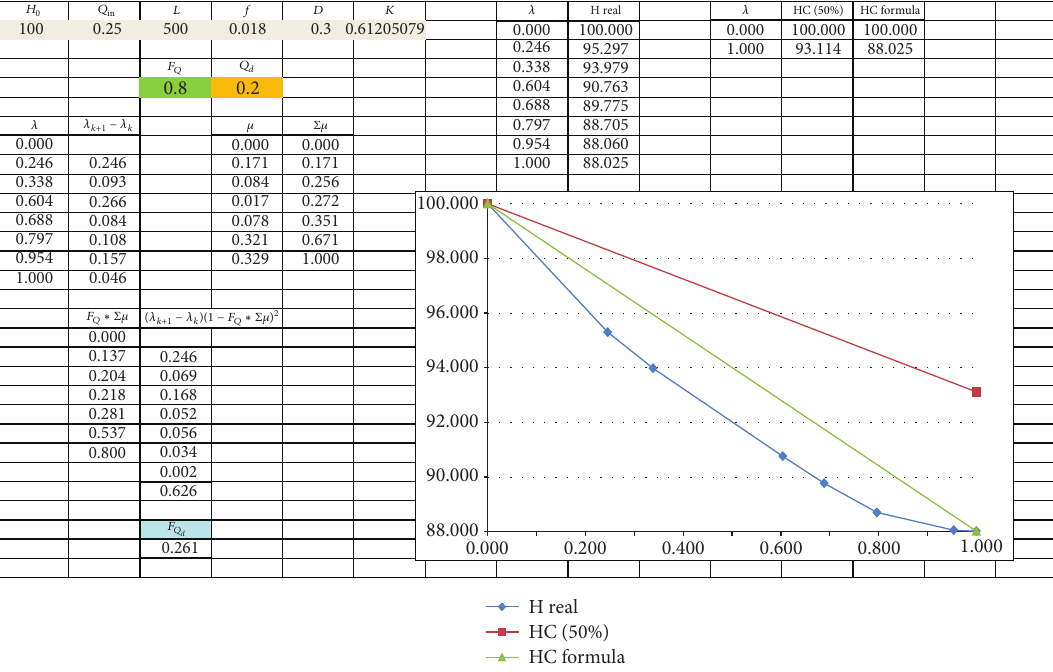
Figure 6: Calculation of 𝐹 𝑄 for a nonuniform distribution of demand within a line and comparison among hydraulic grade 𝑑